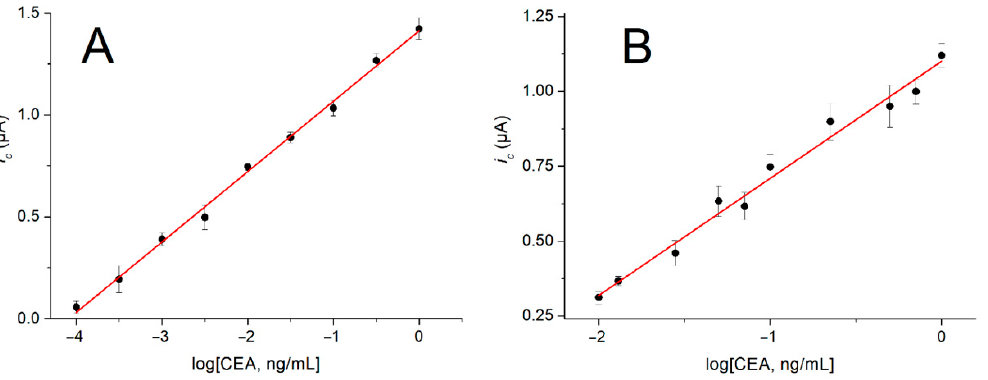
Figure 5. Calibration curves for CEA aptasensor in buffered solutions ( A ) and diluted human serum samples ( B ).